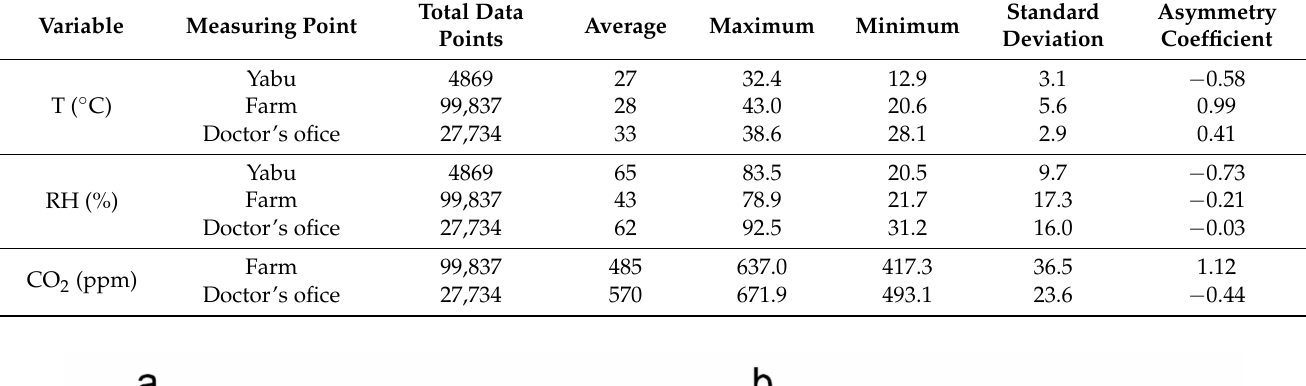
Table 4. Descriptive statistics for the time series registered over this field study.